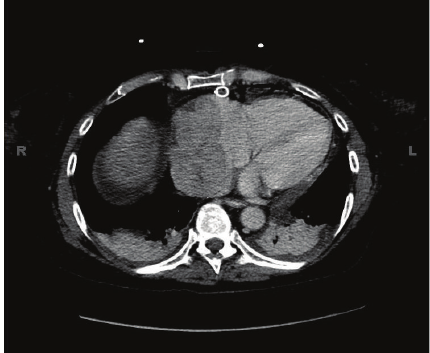
Figure 1: Right cardiac atrial mass shown by CT scan extending into the inferior vena cava, involving the superior vena cava as it enters the atrium, and pericardial e ff